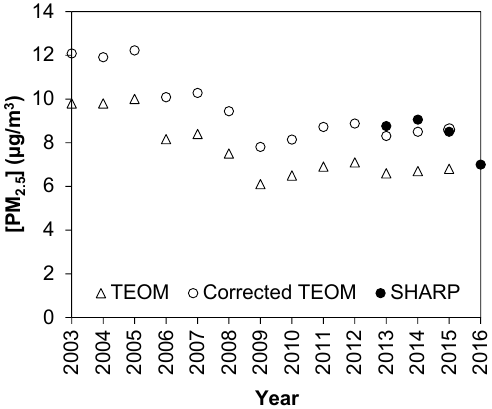
Figure 8. Annual PM 2.5 concentrations for the TEOM, corrected TEOM, and the SHARP from 2003 to 2016 at the Toronto West station.